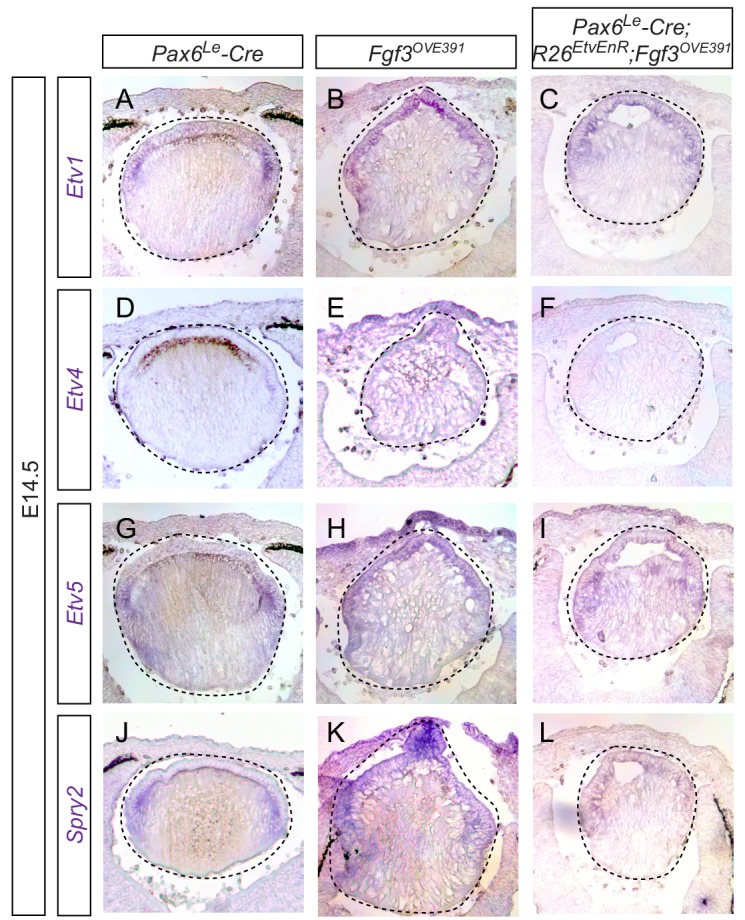
Fgf3 overexpression stimulates expressions of Etv and Spry in the lens.(A–L) Overexpression of Fgf3 in Fgf3OVE391 led to upregulation of Etv1, 4, five and Spry2 in the anterior lens epithelium, which were greatly reduced by expression of dominant negative EtvEnR.